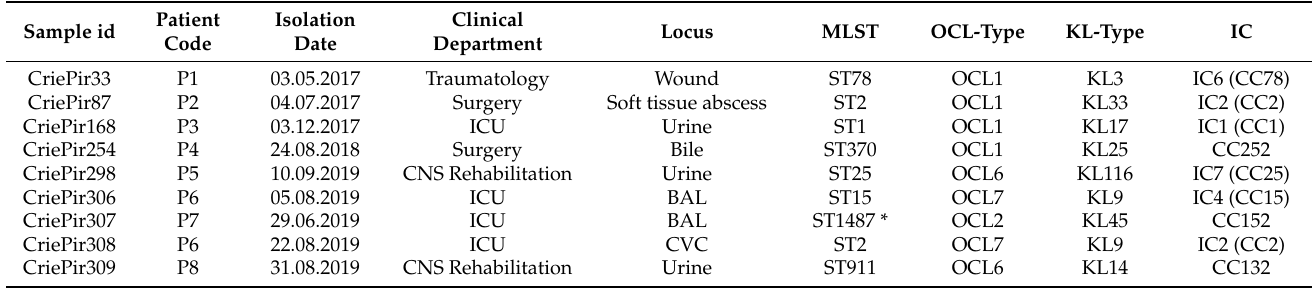
Table 1. The origin and typing of the clinical A. baumannii isolates